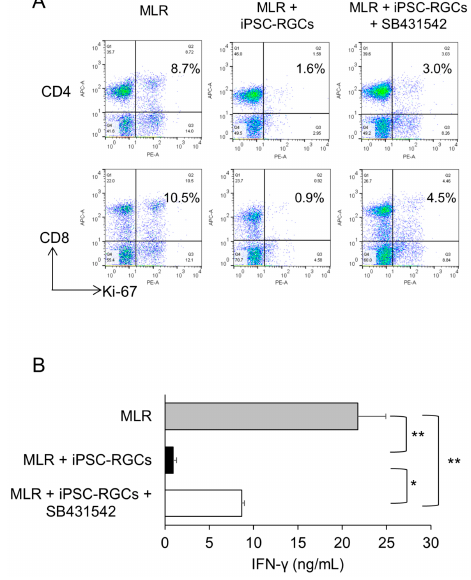
Figure 7. Capacity of TGF- β derived from iPSC-RGCs to suppress activation of T-cells. MLR cells were co-cultured with iPSC-RGCs (MLR:RGC ratio = 2:1) in the presence of the TGF- β inhibitor, SB431542. The activation of T-cells was analyzed with Ki-67 FACS and IFN- γ secretion with ELISA. ( A ) Representative data of Ki-67 FACS proliferation analysis. The percentage of double-positive cells that were co-cultured with iPSC-RGCs in the presence of SB431542 increased compared to that in co-cultures without SB431542. Numbers in the scatterplots indicate the percentage of double-positive cells for CD4 or CD8 and Ki-67. ( B ) Secretion of IFN- γ from MLR cells co-cultured with RGCs in the presence of SB431542 was significantly increased compared with no SB431542. The data represent the mean ± SD ( n = 3). * p < 0.05, ** p < 0.01.